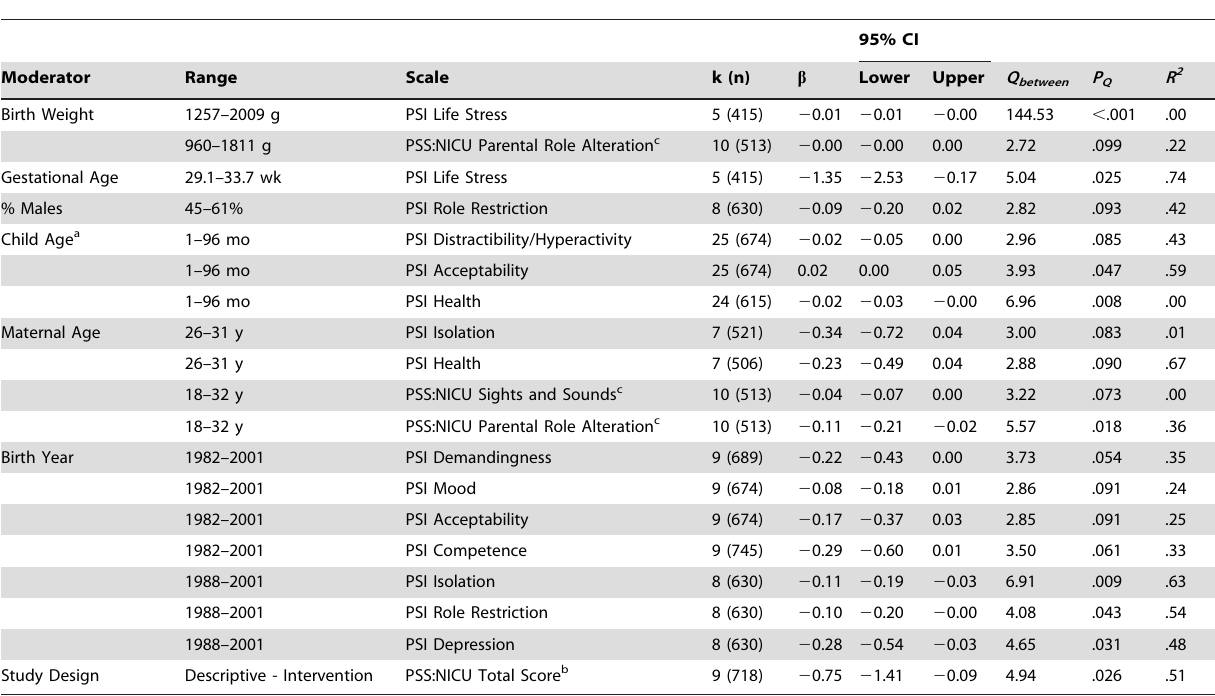
Table 8. Moderator Analyses for Meta-Analytic Mean PSI and PSS:NICU Scores.